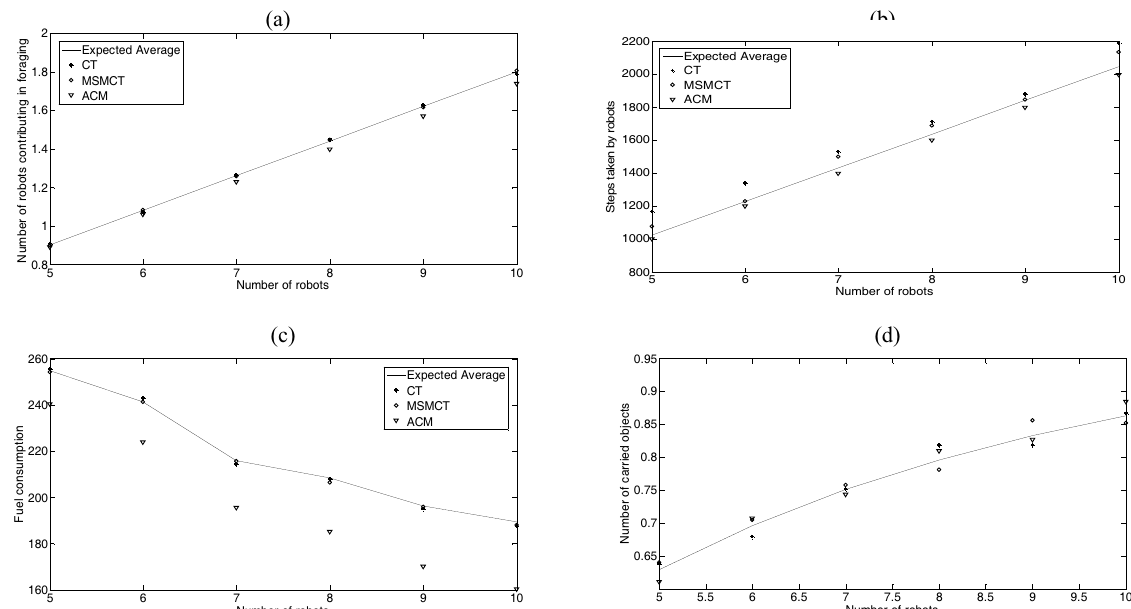
Fig. 13. Monte Carlo simulations of a single-object system. Simulations had run for R =5, ...,10 robots; each for 50 times with random selection of initial position of robots.